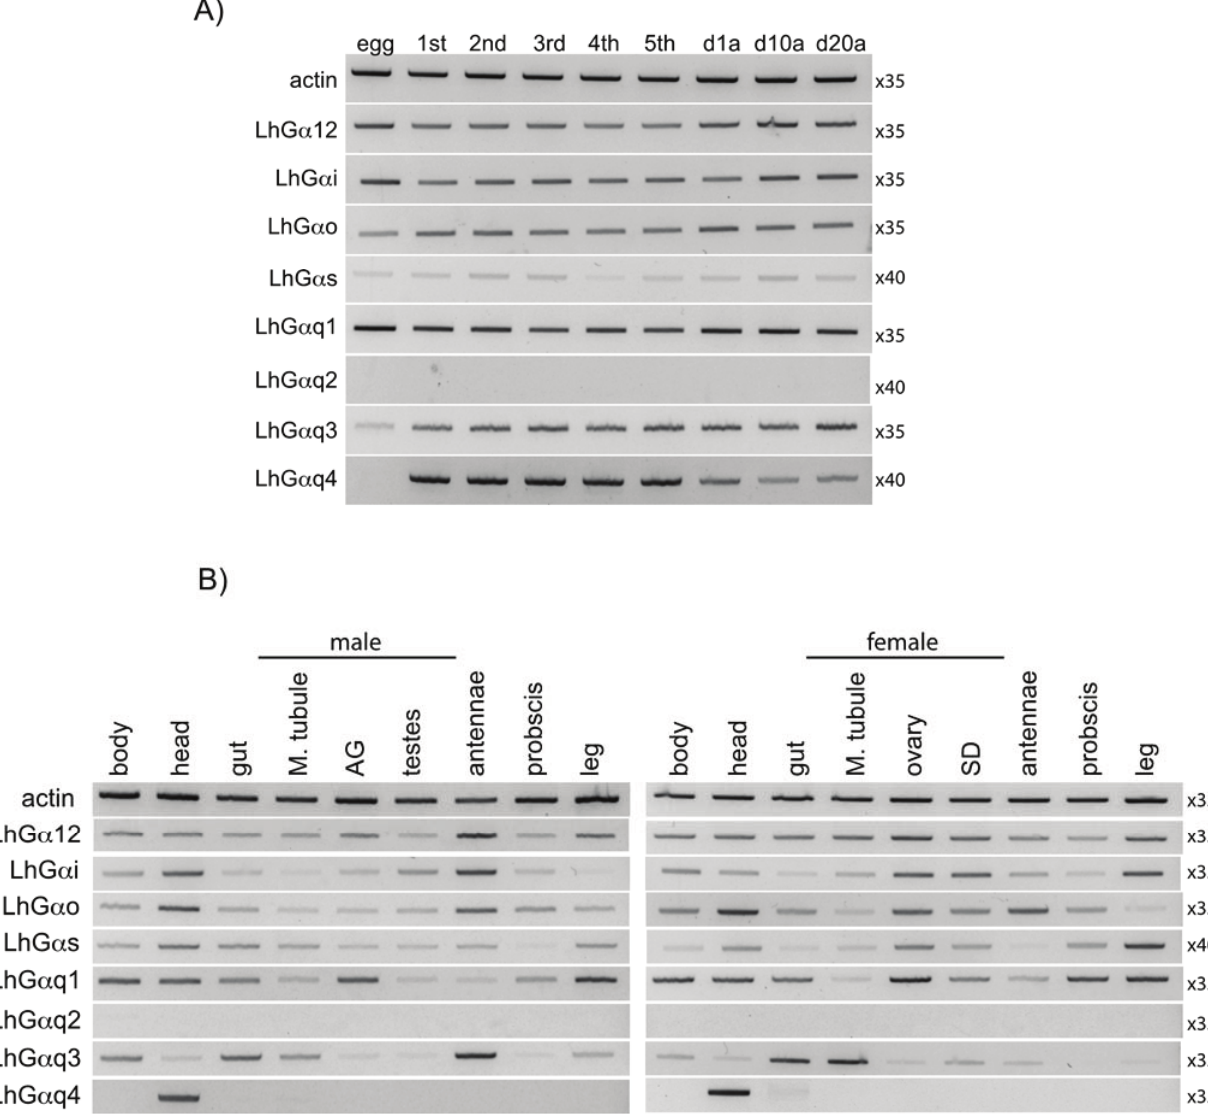
Figure 5. End point PCR-based expression profile of L. hesperus G(cid:2) transcripts. ( A ) Expression profile of LhG(cid:2) sequences in eggs, nymphal development (1st–5th instars), 1-day-old mixed sex adults (d1a), 10-day-old mixed sex adults (d10a), and 20-day-old mixed sex adults (d20a); ( B ) Expression profile of LhG(cid:2) sequences in sex-specific adult tissues. Abbreviations are: M. tubule, Malpighian tubule; AG, accessory glands (lateral and medial); SD, seminal